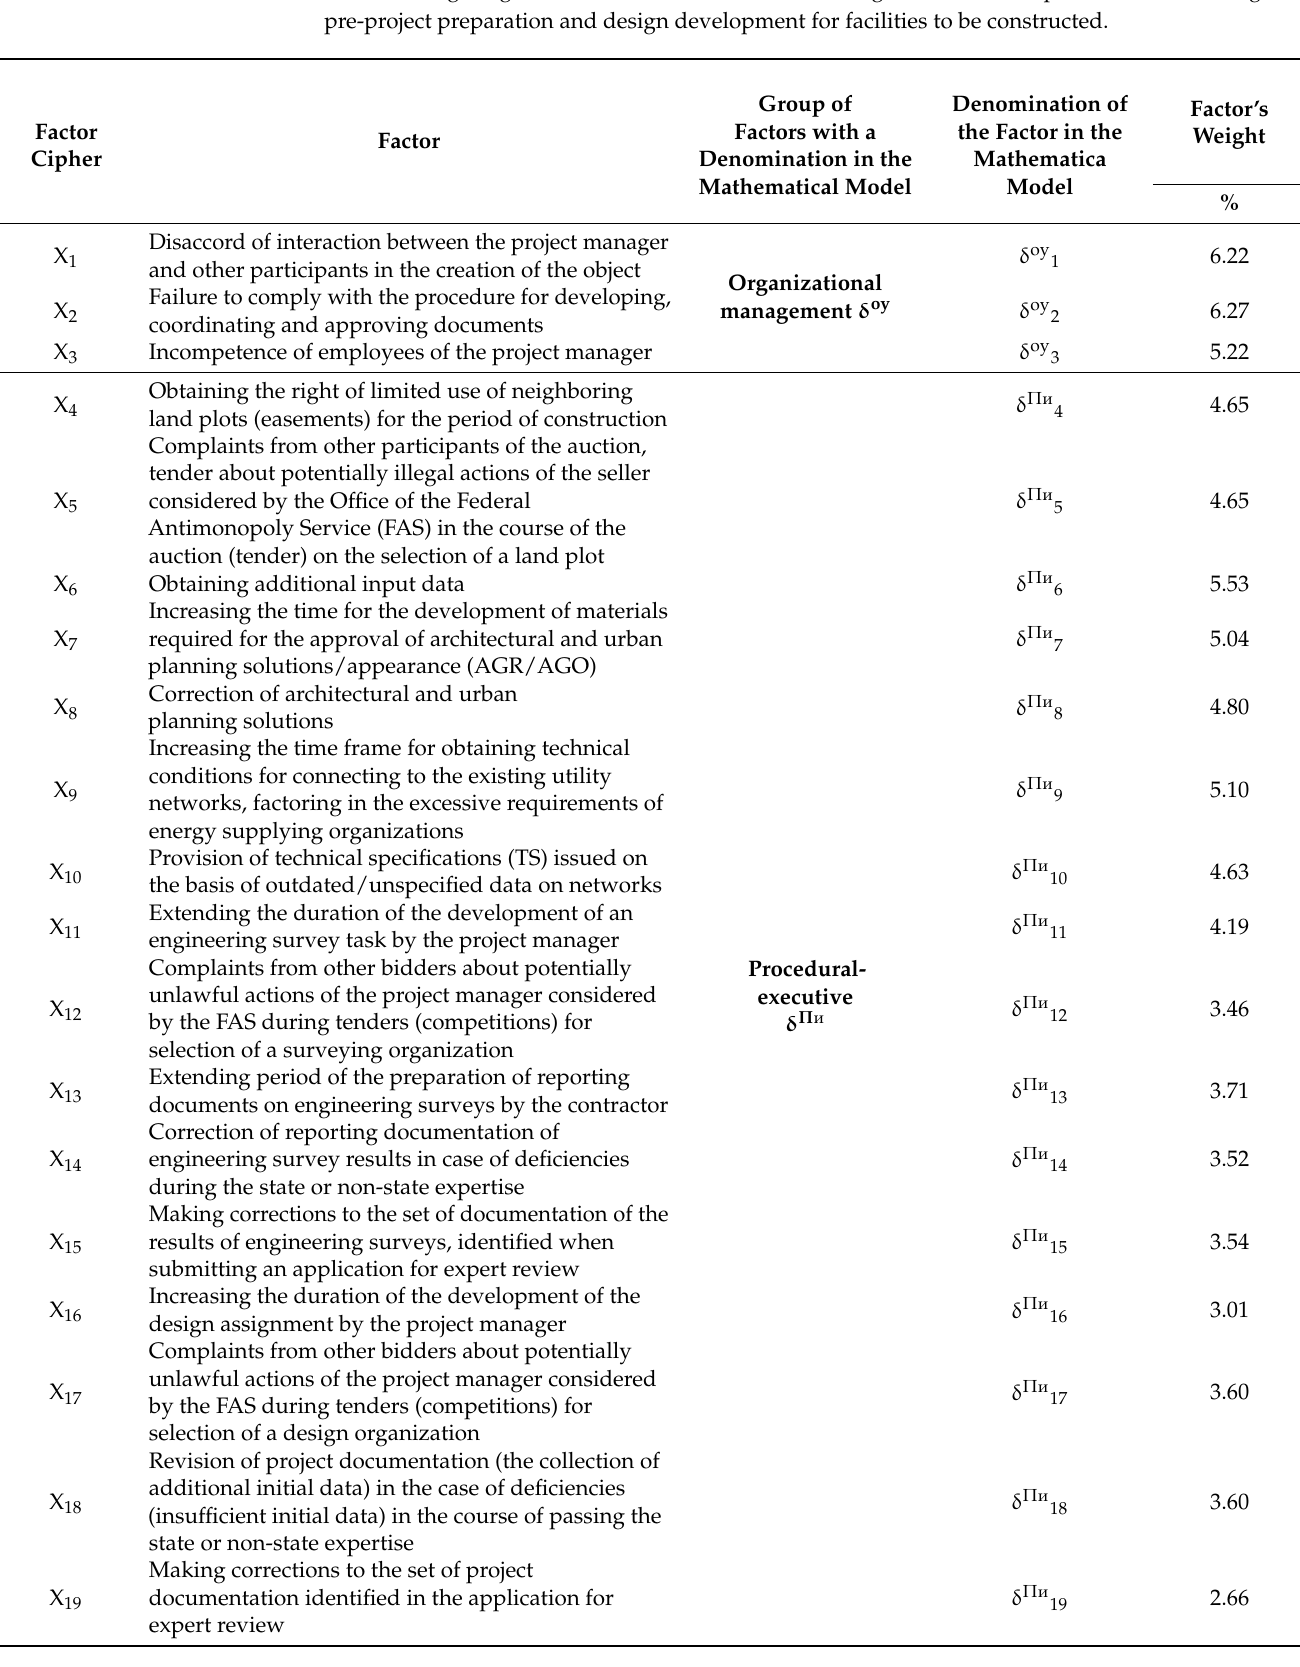
Table 3. Weighting characteristics of the factors affecting the duration of procedures at the stages of pre-project preparation and design development for facilities to be